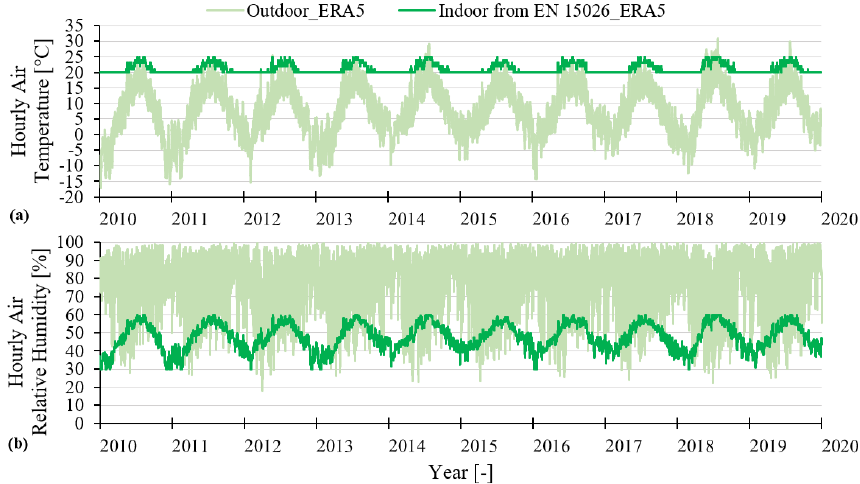
Figure 5. The two different considered cases for the indoor (a) air temperature and (b) relative humidity under the ERA5 climate excitation. The indoor air temperature and relative humidity were in one case equal to the outdoor ones, while in the second case were calculated according to EN 15026.